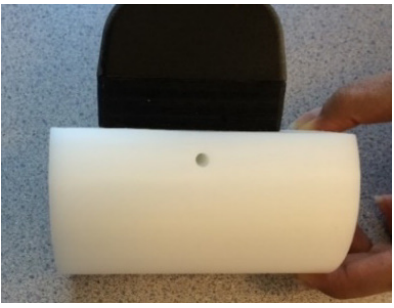
Fig. 4. The breast phantom constructed from Acetal resin